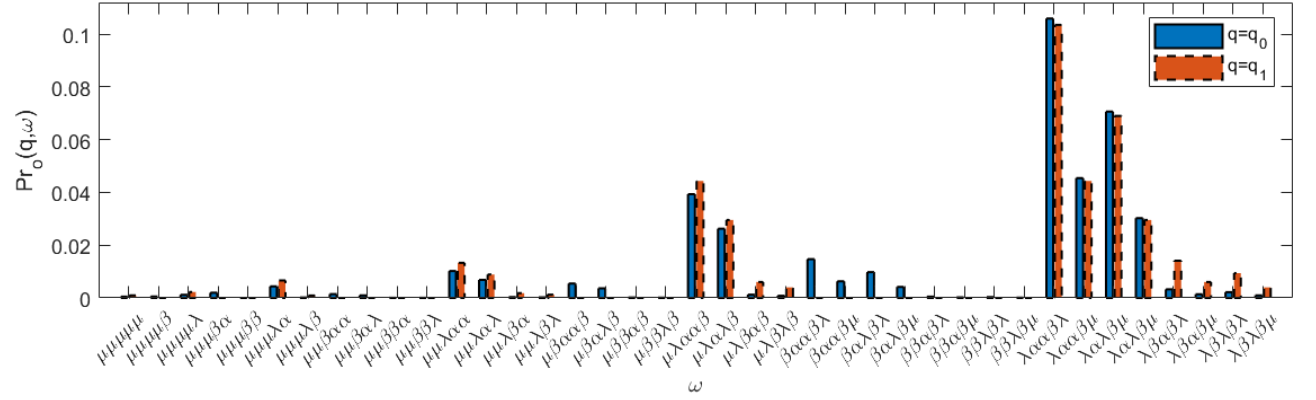
Figure 10. The probability distributions of generating observations with five-step observation exten- sions from q 0 and q 1